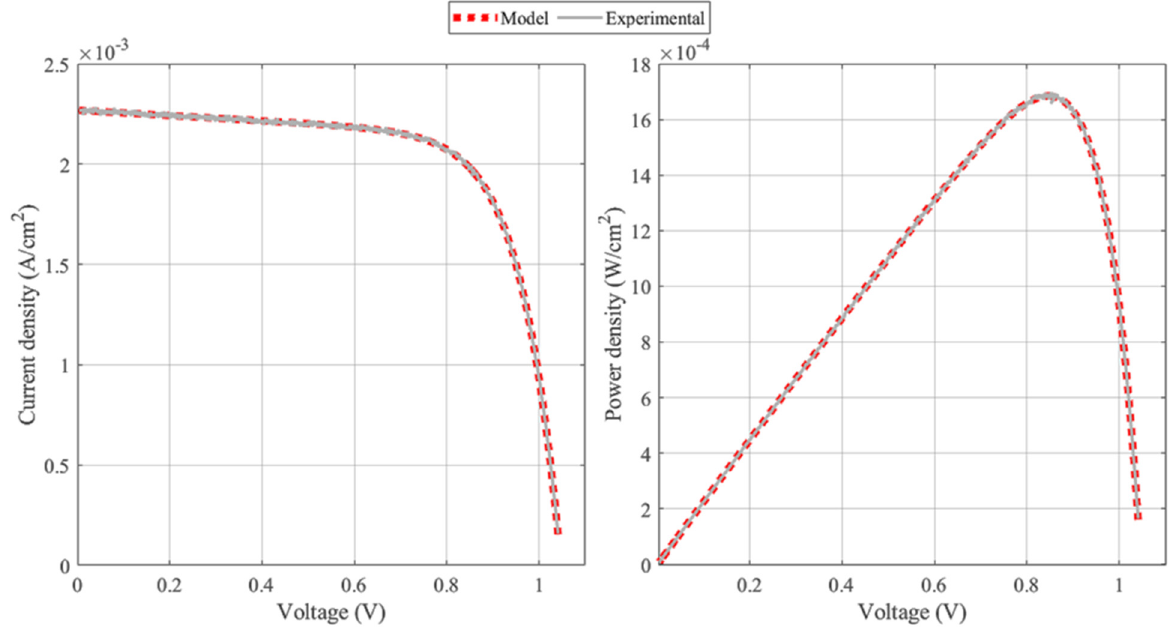
Figure 3. Output characteristic of control PSC using mBES optimizer.